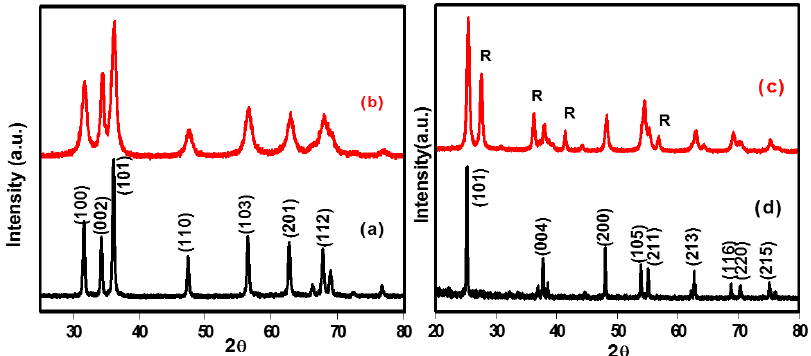
Figure 1. X-ray diffraction (XRD) of ( a ) Pristine ZnO, ( b ) FL–ZnO, ( c ) FL–TiO 2 and ( d ) Pristine TiO 2 .